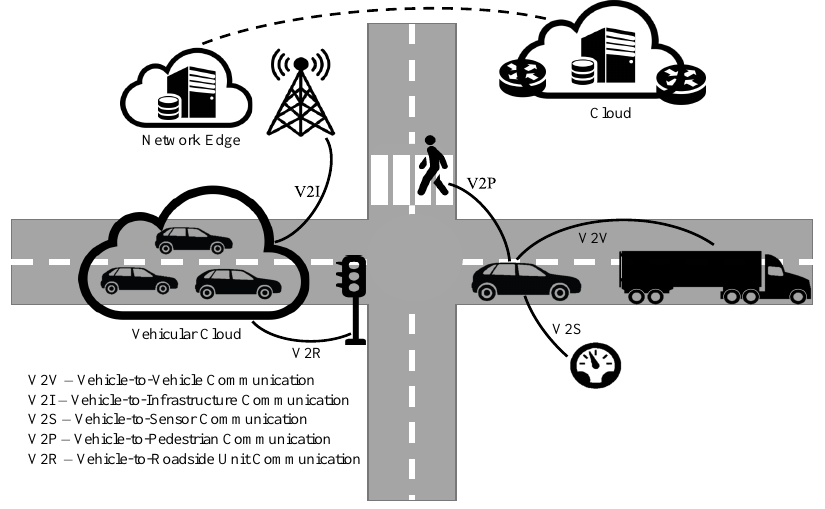
Figure 1. Vehicle-to-Everything (V2X)